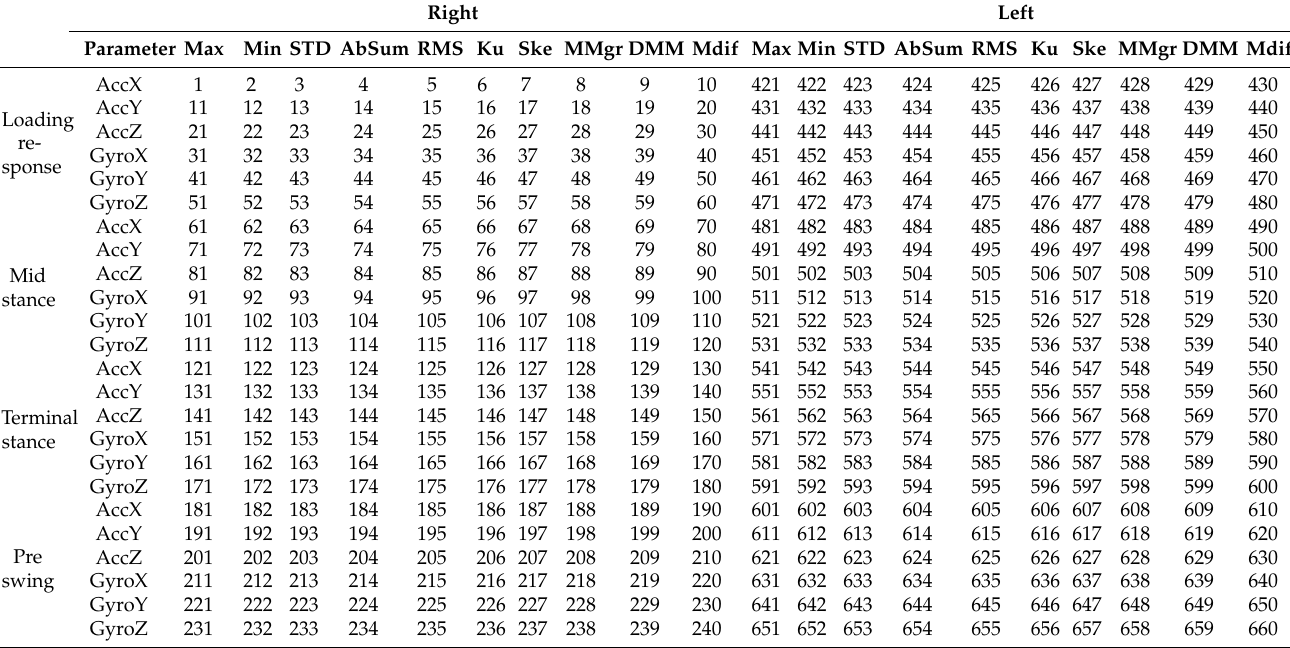
Table A3. Seven phase descriptive statistical parameters. Right